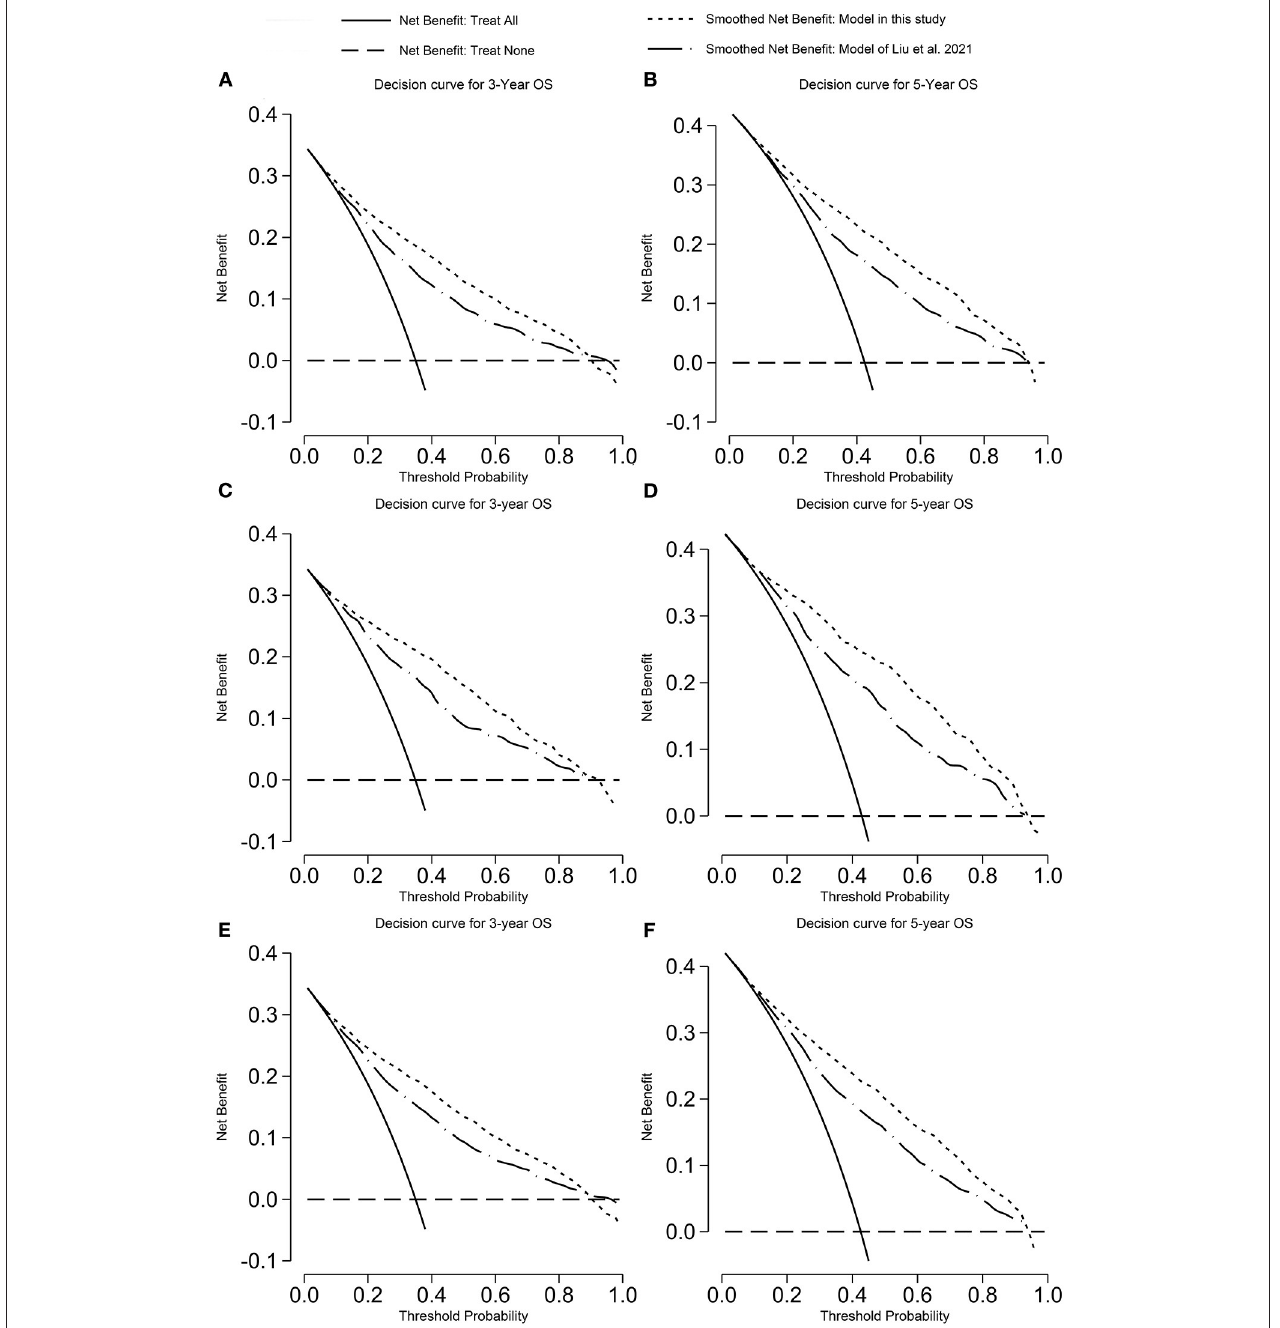
FIGURE 2 | Decision curve analysis on the model predicting OS. (A) 3-years OS in the training cohort; (B) 5-years OS in the training cohort; (C) 3-years OS in the validation cohort; (D) 5-years OS in the validation cohort; (E) 3-years OS in the overall cohort; and (F) 5-years OS in the overall cohort. OS, overall survival.